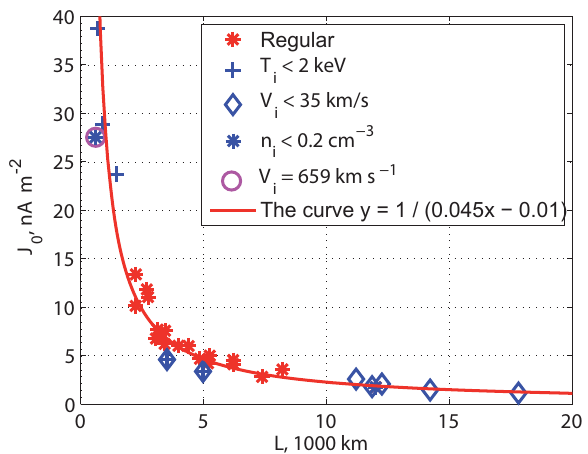
Figure 10. Analytical model units: current density J 0 vs. spa- tial scale L from Eqs. (17) and (18) for Cluster data of cur- rent sheet crossings, presented in Table1 of Runov et al. (2006). Blue crosses show cases of the lowest ion temperature, T i < 2keV (8,9,12,13,14 in Table1 of Runov et al., 2006); blue dia- monds show cases of the lowest ion drift velocity, V i < 35kms − 1 (8,9,10,19,21,29,30); and blue asterisks show cases (20,24) of the lowest ion number density, n i < 0 . 2cm − 3 . Magenta circle shows the case 20 of extremely high velocity, V i = 659kms − 1 . All other “regular” cases are shown by red asterisks. The red line plots the fitting curve y = 1 /( 0 . 045 x − 0 . 01 )